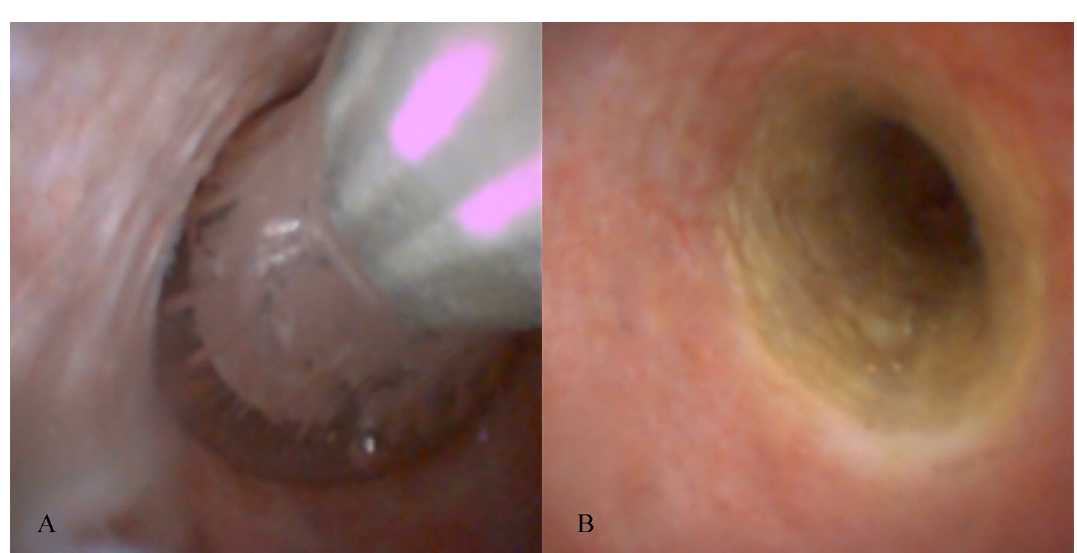
Figure 2. After obtaining the cholangiogram and achieving guidewire placement in the bile duct ( A ), a cholangioscope is inserted, and radiofrequency ablation with a balloon-based catheter is subsequently performed under cholangioscopic and fluoroscopic guidance ( B ).